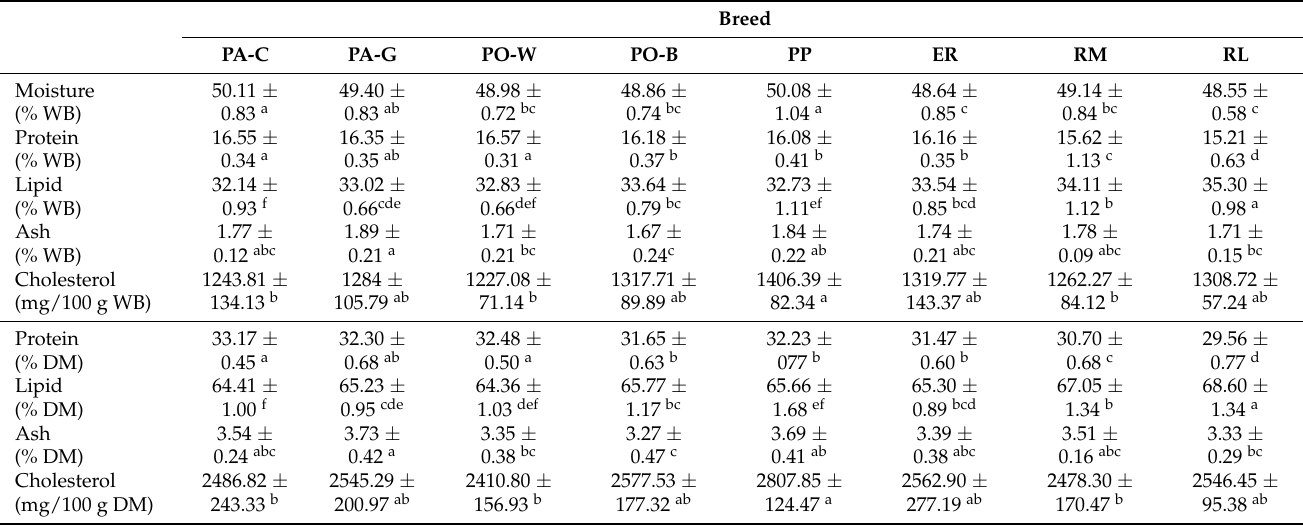
Table 2. Least-squares means and standard error of composition of yolk for the breed